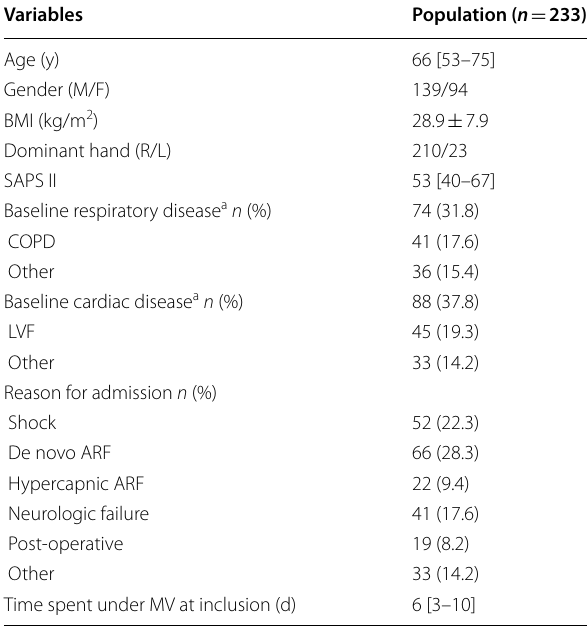
Table 1 Characteristics of the